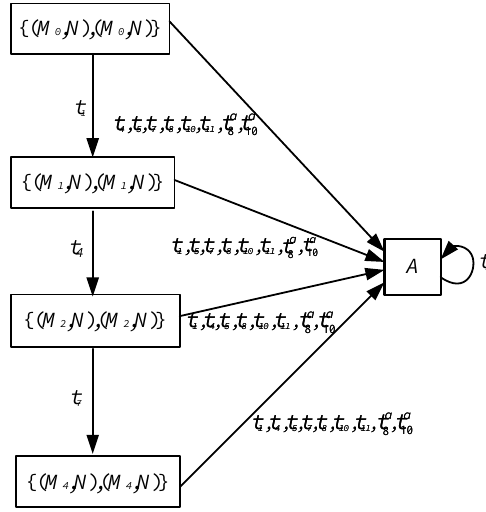
Figure 13. The basis verifier under attacks G cd